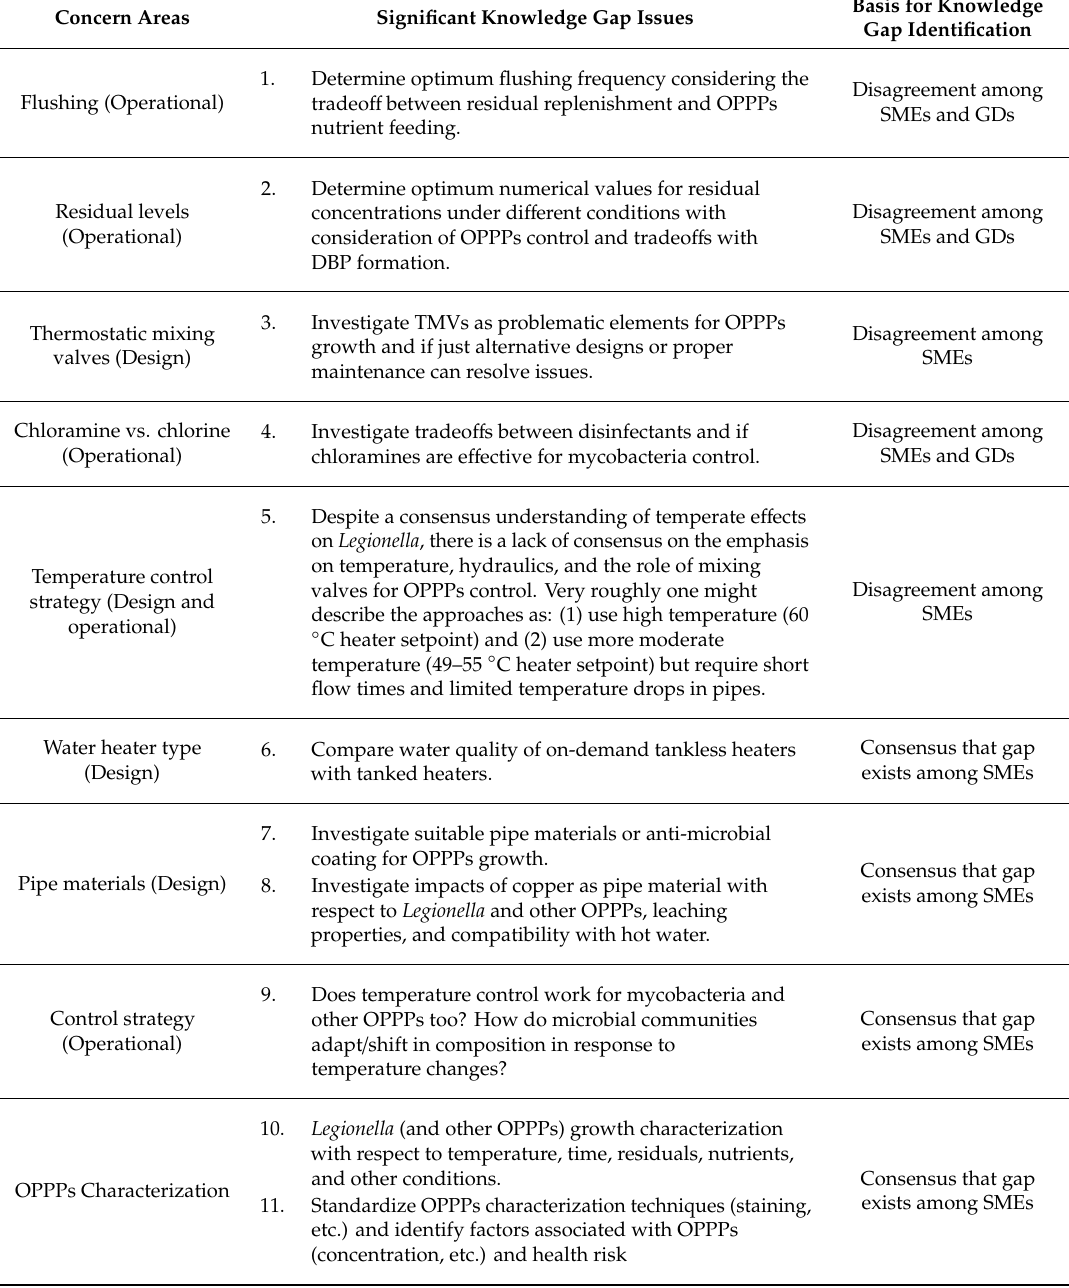
Table 6. Summary of the key knowledge gap issues in premise plumbing based on SME